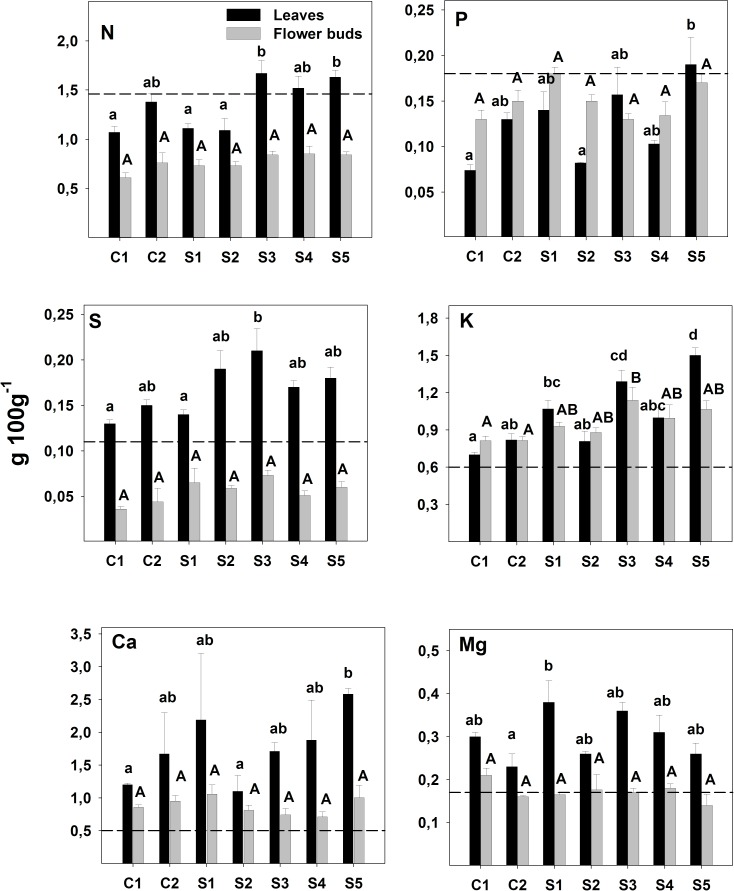
Nutrient concentrations in E. camaldulensis leaves and flower buds (mean ± standard error).Significant differences (p < 0.05) among sites for leaves composition (black bars) are marked with lower case letter, while difference for flowers buds (grey bars) are in capital letters. As reference for each nutrient, a dotted line indicates the lower limit of the range considered adequate for E. camaldulensis normal growth [58].